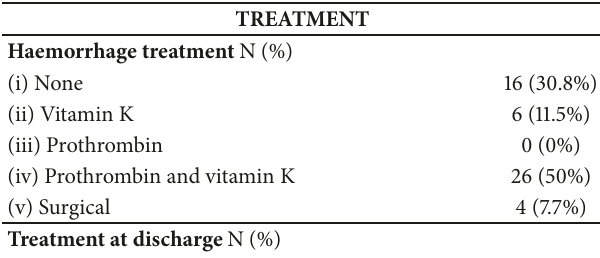
Table 2: Characteristics of ICH. Table 3: